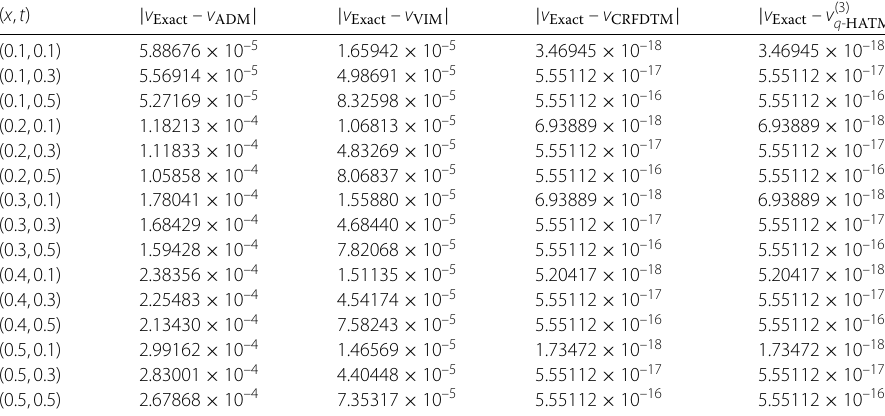
Table 2 Comparative study in terms of absolute error between ADM [28], VIM [29], CFRDTM [26] and q -HATM for the approximate solution v ( x , t ) at ω = 0.005, (cid:13) = 0.1, c = 10, (cid:2) = –1, n = 1, (cid:2) = –1 and α = 1 for Example 6.1